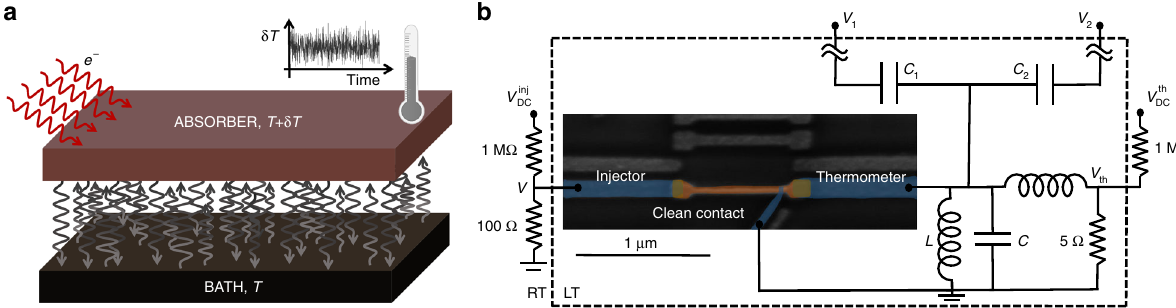
Fig. 1 The set-up for measuring temperature fl uctuations. a The calorimeter principle applied to the electronic system in this work. The normal-metal absorber in the center is subjected to the fl uctuating heat current from the phonon bath below. Additionally we have an option to create nonequilibrium by injecting “ hot ” electrons as indicated by red arrows on the left. A key element in the calorimeter is a thermometer with suf fi cient bandwidth to provide temporal temperature traces, of which an example is shown above the absorber. b The measurement set-up including the colored scanning electron micrograph of the sample in the center. The ‘ ¼ 1 µ m long Cu absorber (brown) coupled to two superconducting Al leads (blue) via tunnel barriers (bronze). The clean metal-to-metal contact to another superconducting Al lead pointing down at an inclined angle provides the proximity effect for the thermometer and a fi xed chemical potential for the absorber. The circuit on the sample stage at low temperature (LT) within the dashed area presents the RF readout of the thermometer junction with tunnel resistance 18 k Ω composed of an LC resonator and probed by RF transmission measurement between ports V and V . The rest of the set-up at room temperature (RT) is for DC biasing of both the injector ð V Þ and thermometer ð V 1 2